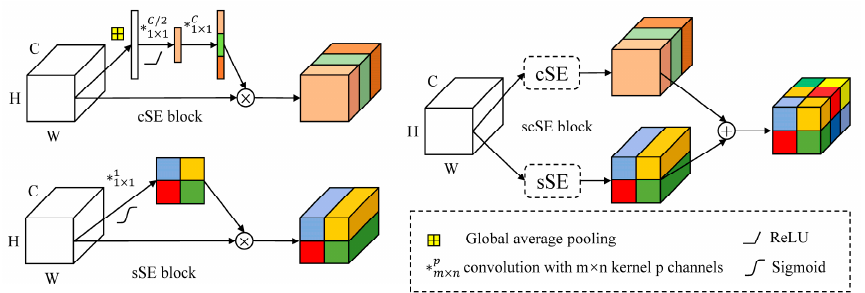
Figure 4. Operation flow chart of cSE, sSE and scSE.